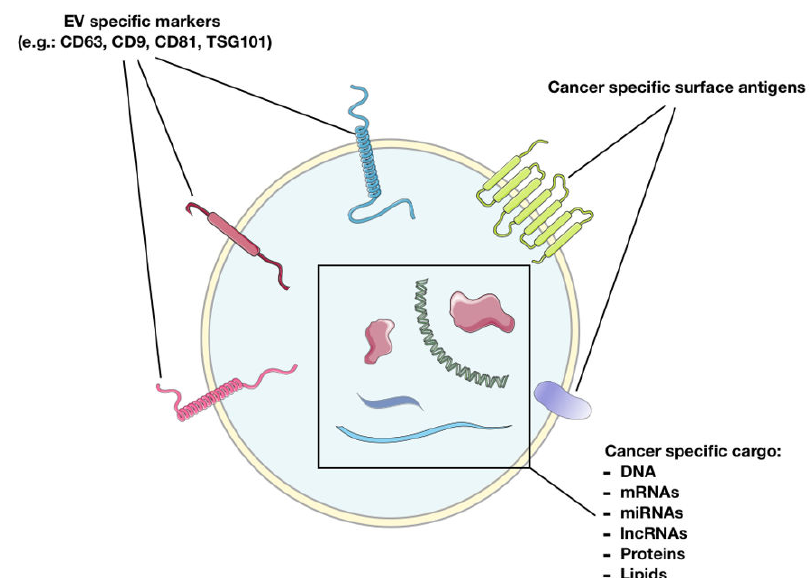
Figure 1. Cancer-derived EV content. Based on the presence of specific EV markers and cancer cell specific markers, EVs may serve as valuable diagnostic tools. CD: Cluster of Differentiation, miRNAs: micro RNAs, lncRNAs: long non-coding RNAs. This figure has been created by Emilio Venturelli using Servier Medical Art templates, which are licensed under a Creative Commons Attribution